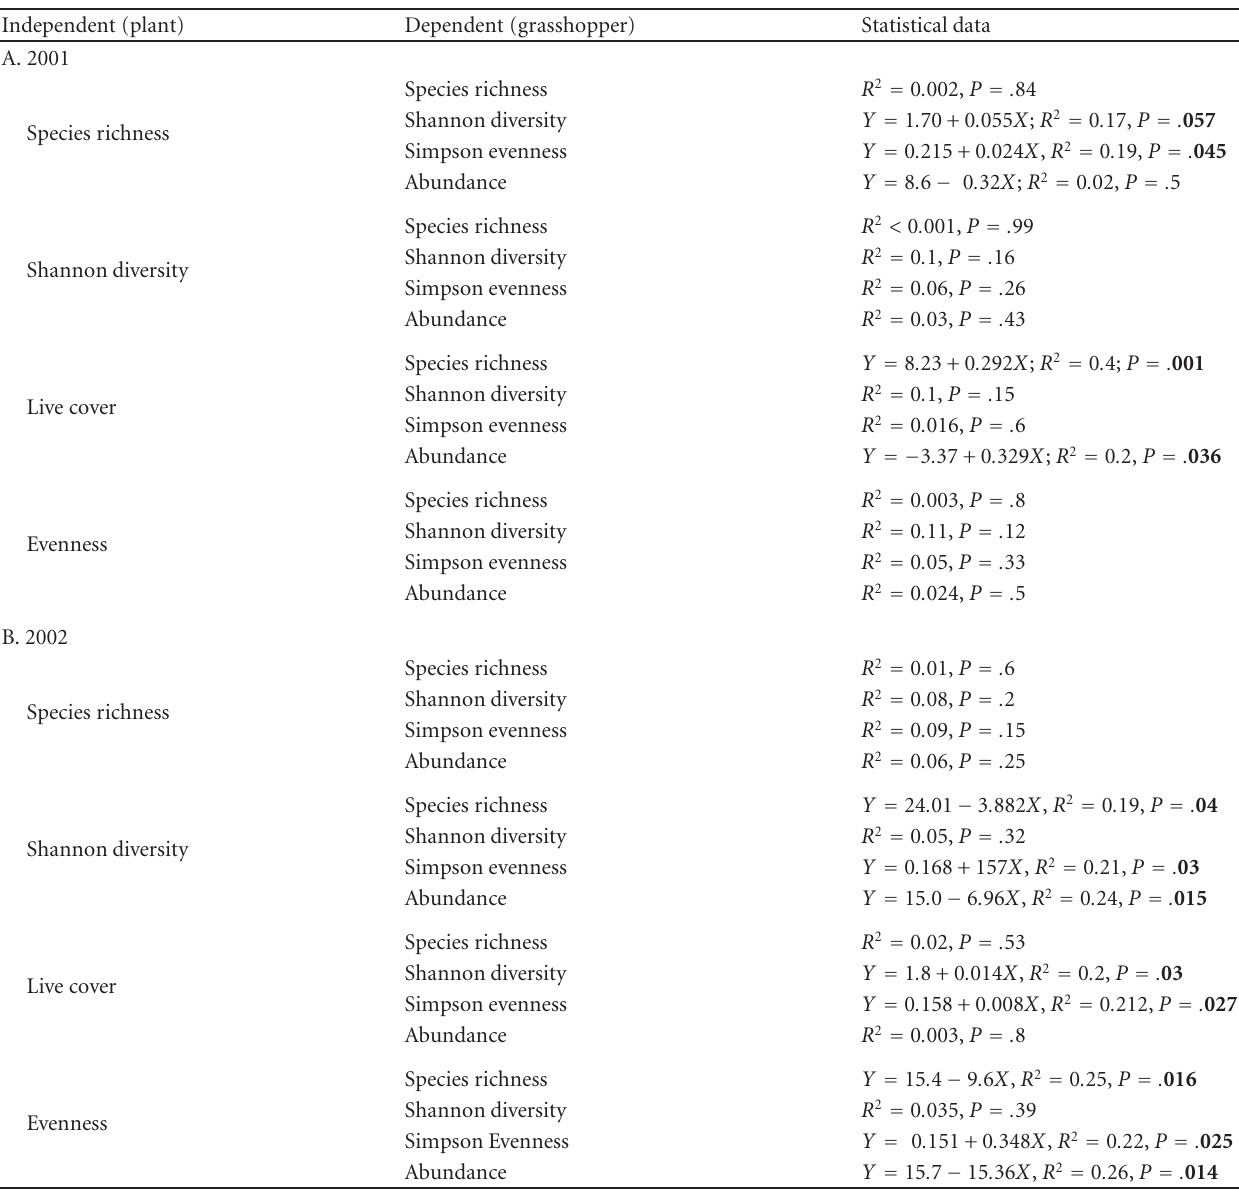
Table 3: Results from regression analyses of plant species richness, live cover percentage, Shannon diversity, and Simpson evenness on grasshopper abundance and diversity. Regression equations are provided for results with a P value less than